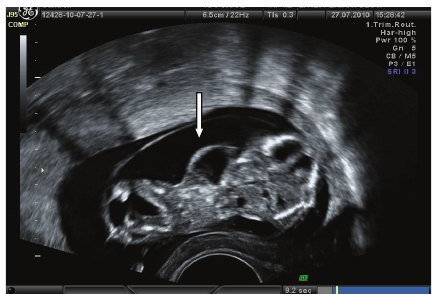
Figure 1: The large omphalocele and herniated liver.